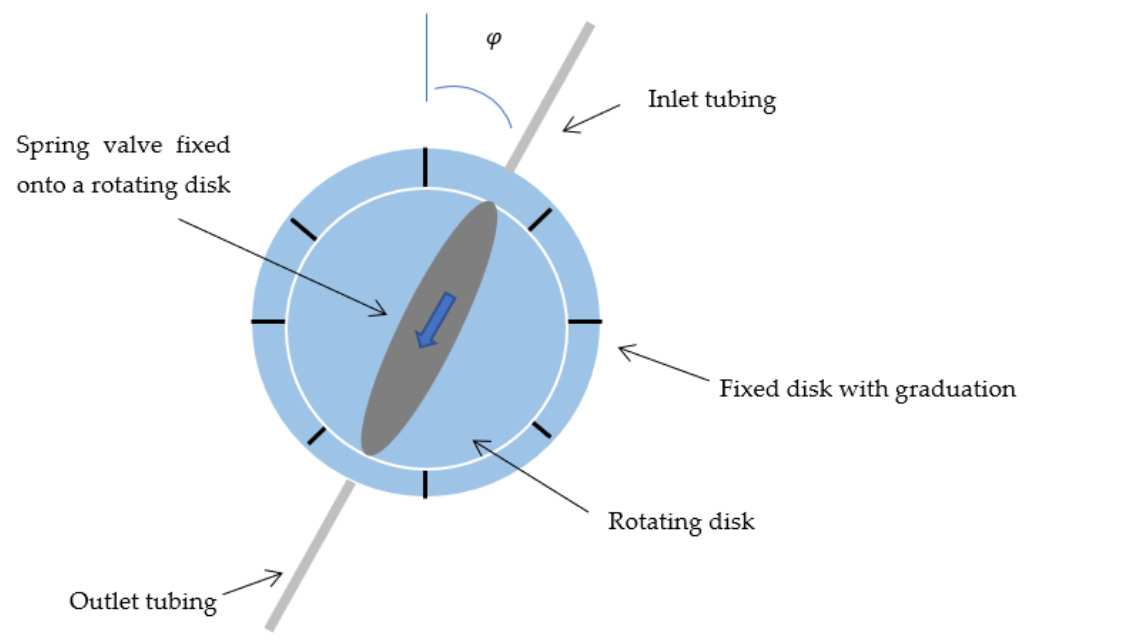
Figure 7. Spring valve mounted onto a rotation disk for gravimetric flow adjustment. The blue arrow indicates the direction of the flow. The rotation of the disk modifies the initial spring preload by gravimetry.